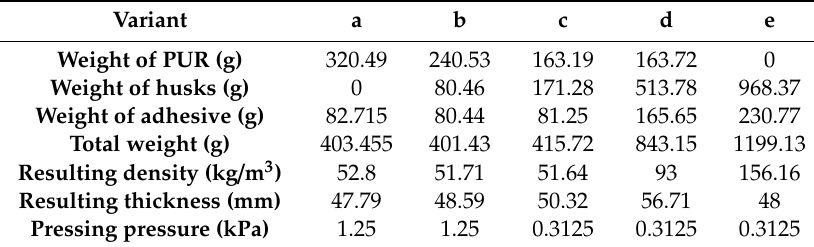
Table 2. Actual production